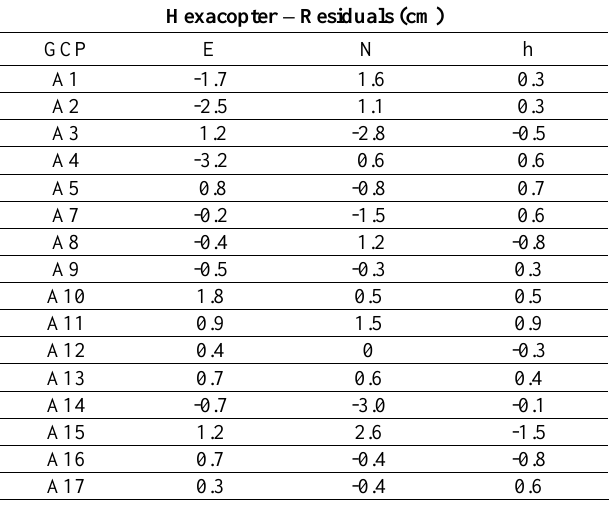
Table 3a. Georeferencing residuals on GCPs measured in nRTK